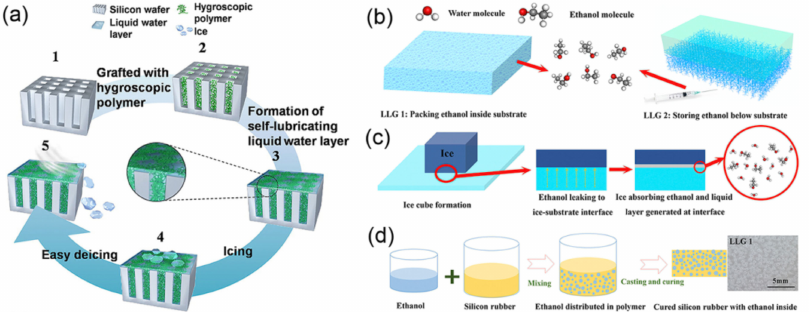
Figure 11. ( a ) Schematic illustration of the preparation of a self-lubricating liquid water layer surface: ( 1 ) Fabrication of microstructured silicon wafer. ( 2 ) Grafting hygroscopic polymers onto microstructured silicon wafer. ( 3 ) Self-lubricating liquid water layer forms on microstructured silicon wafer once the condensation occurs. ( 4 ) Ice formation atop of the self-lubricating liquid water layer. ( 5 ) Ice shed off with a wind action. Schematic illustration of the strategies of generating a liquid layer at the ice–substrate interface: ( b ) two strategies to create icephobic lubricating surfaces; ( c ) mechanism of generating a liquid ethanol layer at the ice–substrate interface; ( d ) fabricating method of lubricating surfaces: mixing ethanol with silicone rubber that can be quickly cured at room temperature, following which ethanol will be packed inside the substrate after curing. ( a ) Reproduced with permission from Ref. [76], Copyright 2013 American Chemical Society; ( b – d ) reproduced with permission from Ref. [100], Copyright 2019 The Royal Society of